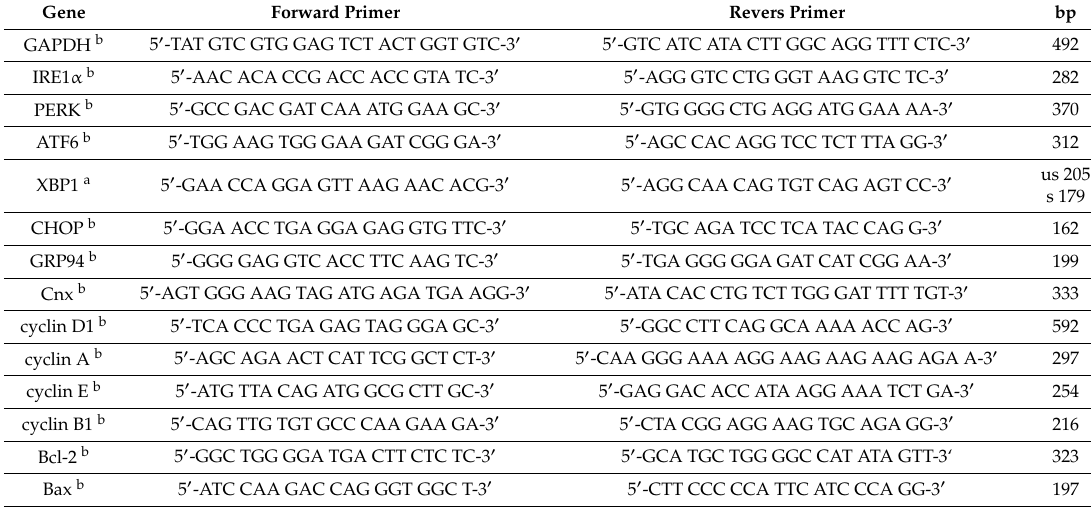
Table 1. Primers for